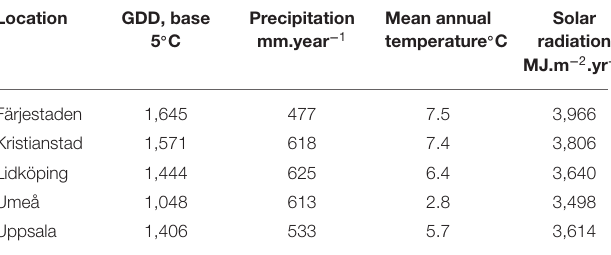
TABLE 2 | Summary of the baseline climate for each location.